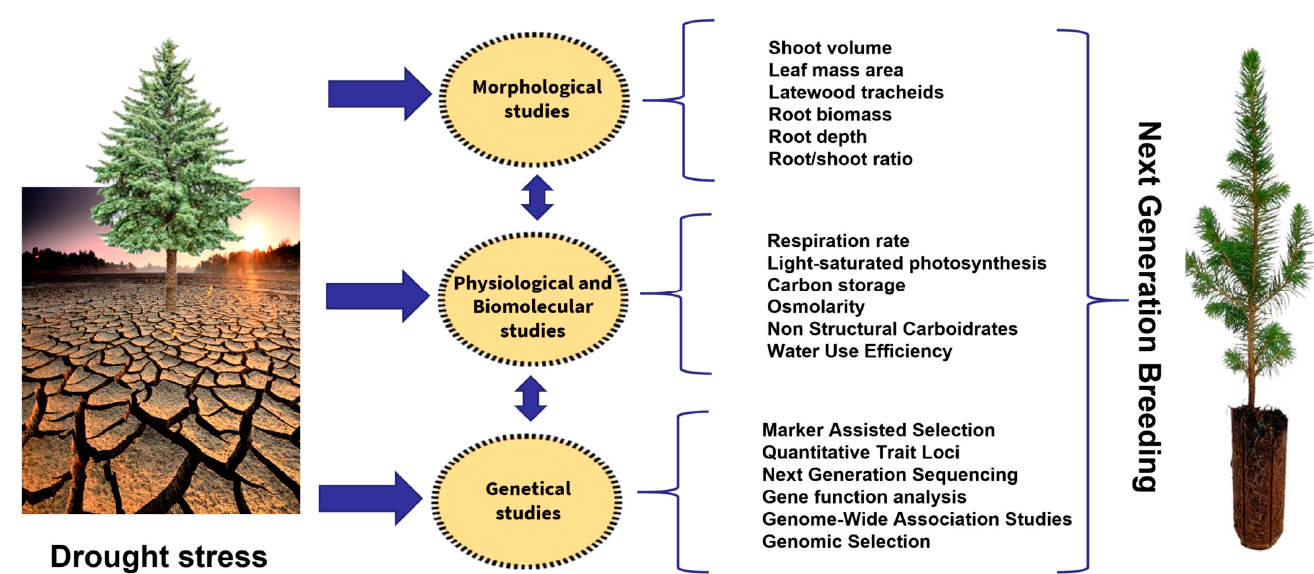
Figure 2. Next-generation breeding processes to improve drought stress in conifers.